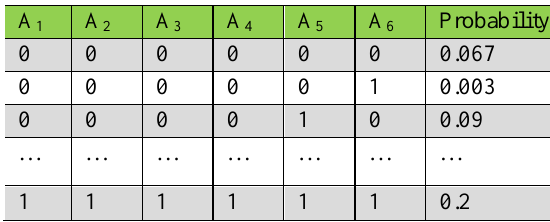
Table 2. The joint distribution of the dataset